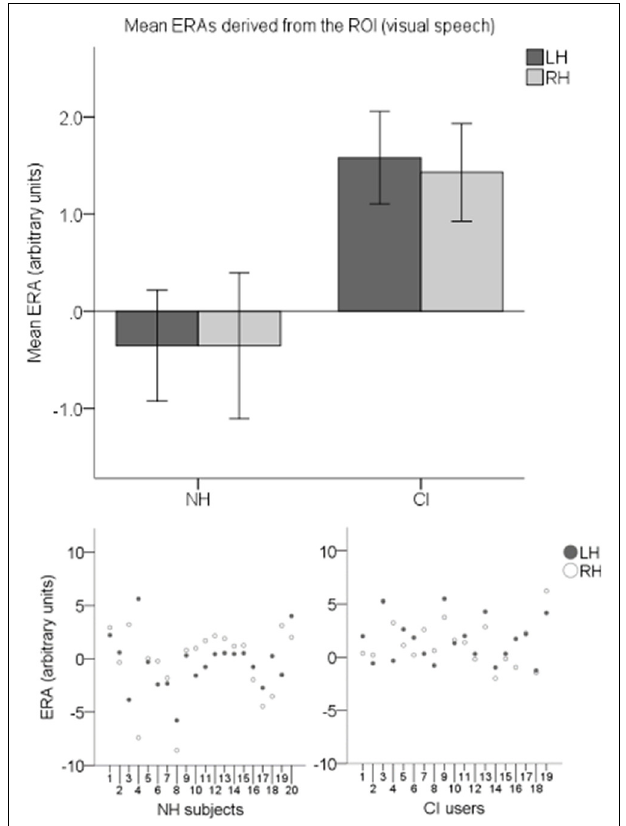
FIGURE 10 | Individual ERAs and group level means ( N = 39) derived from the ROI for the auditory speech condition. The bar chart shows mean ERAs for each group corresponding to channels 9, 10, and 12 in the LH and channels 20, 21, and 23 in the RH. Error bars show ± 1 standard error of the mean. Scatterplots showing individual ERA values are displayed underneath for each